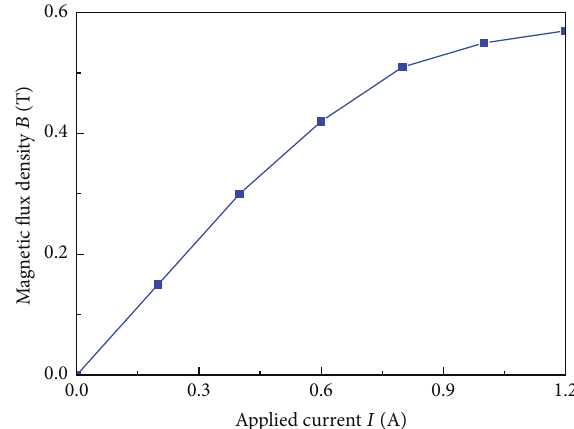
Figure 5: Magnetic flux density under different applied current.